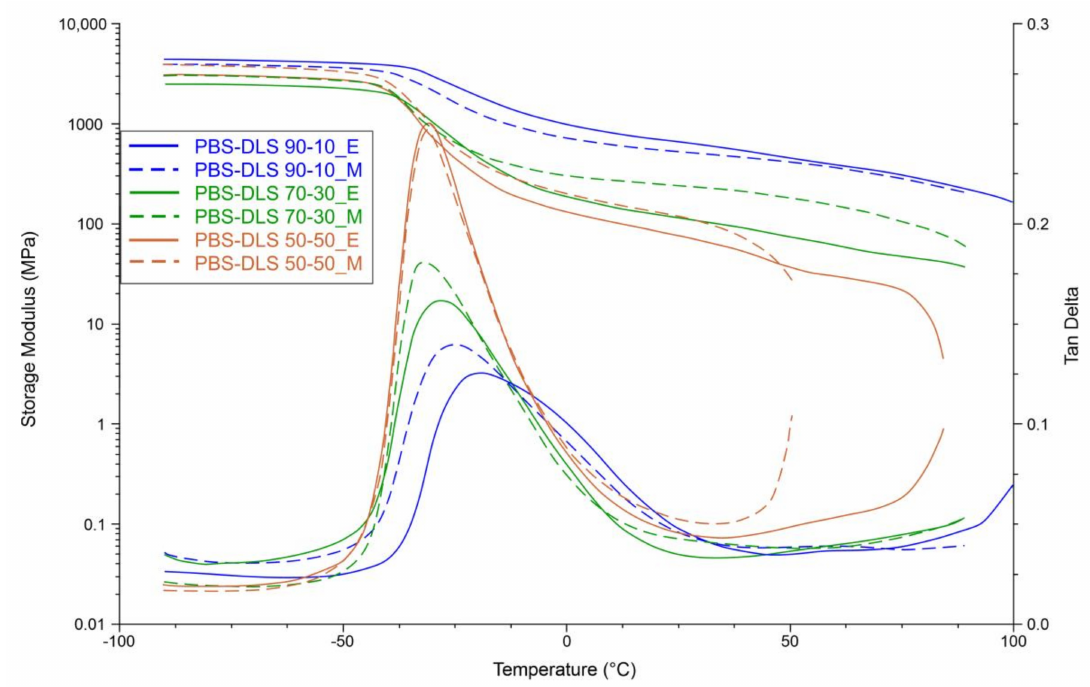
Figure 14. DMTA traces of the PBS-DLS